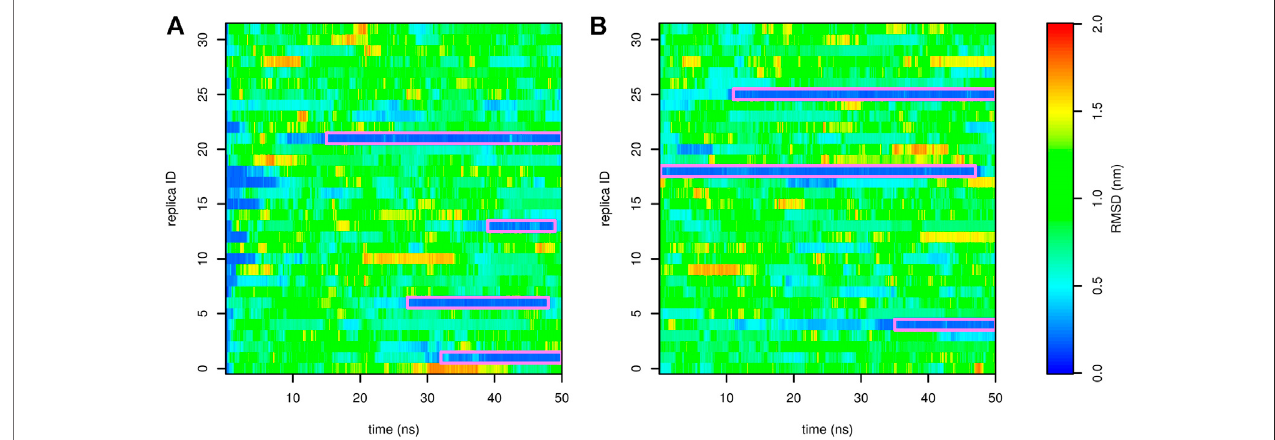
FIGURE 5 | Pro fi les of RMSD of Trp-cage as a function of time calculated for demultiplexed trajectories from the run stared from the folded ( (A) , the fi rst run) and unfolded ( (B) , the second run) state. The folded state is highlighted by a purple frame.